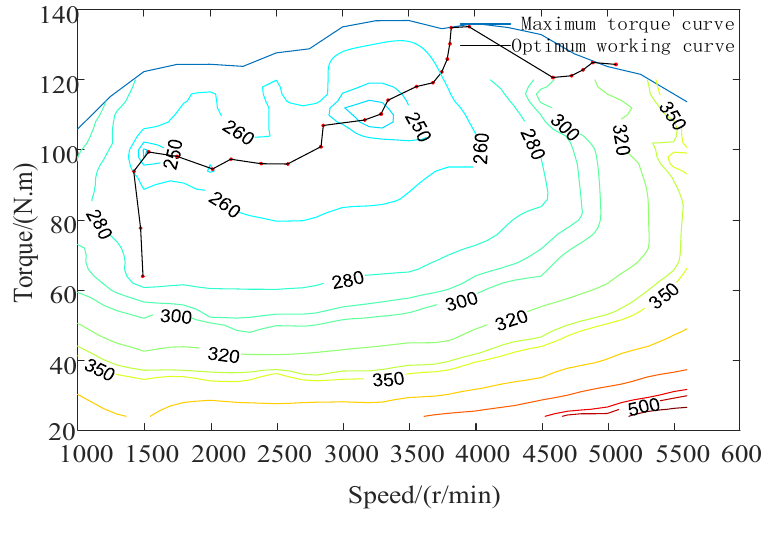
Figure 3. Optimal operating curve of motor.